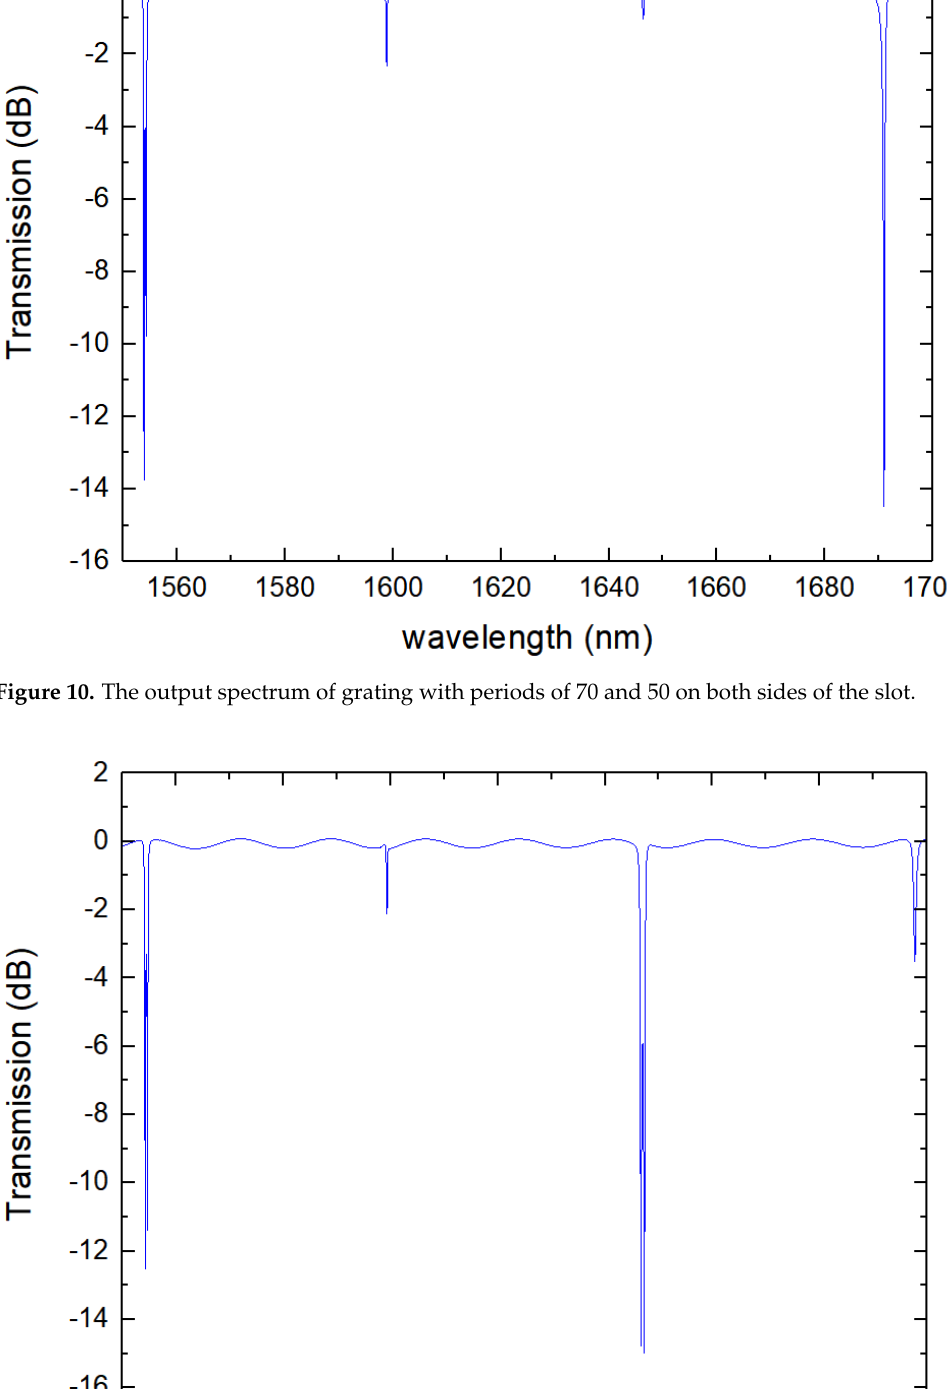
The Q factor and FSR in both cases are calculated by Equations (8) and (9). The sim-